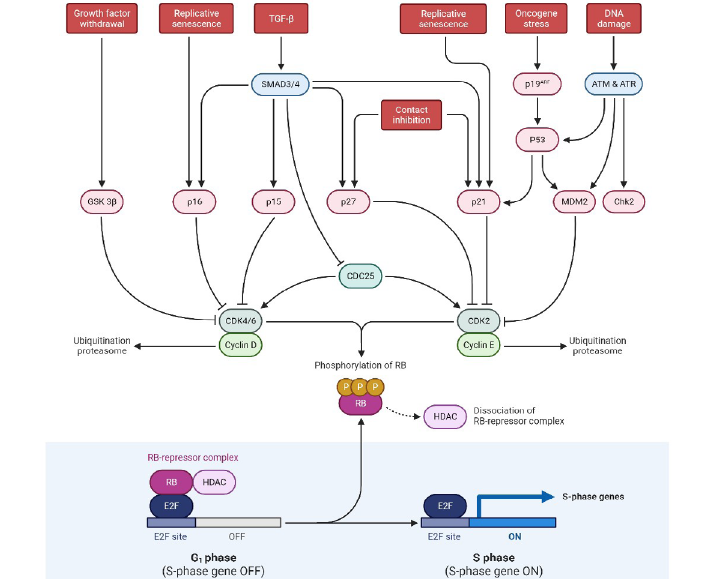
Figure 1. Schematic representation exhibiting p53 and RB pathways at the tumor site. SMAD3/4: small mothers against decapentaplegic 3/4; ATM: ataxia telangiectasia mutated; ATR: ataxia telangiectasia and rad3-related; Chk2: checkpoint kinase 2; CDK2: cyclin dependent kinase 2; HDAC: histone deacetylase; E2F: E2 factor; CDC25: cell division cycle 25; GSK 3β: glycogen synthase kinase 3 beta; G phase: growth 1 phase; S phase: synthesis phase; TGF-β: tumor growth 1